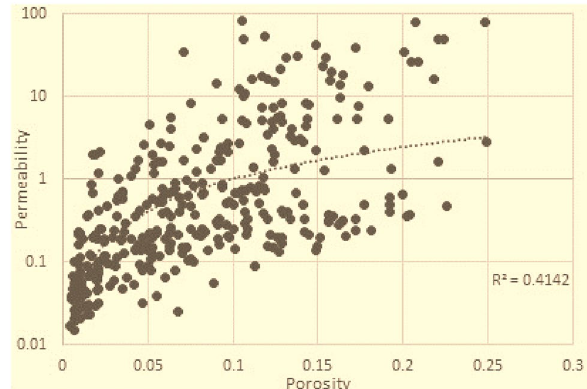
Fig. 11 Porosity vs. permeability plot of the core data for the Kangan